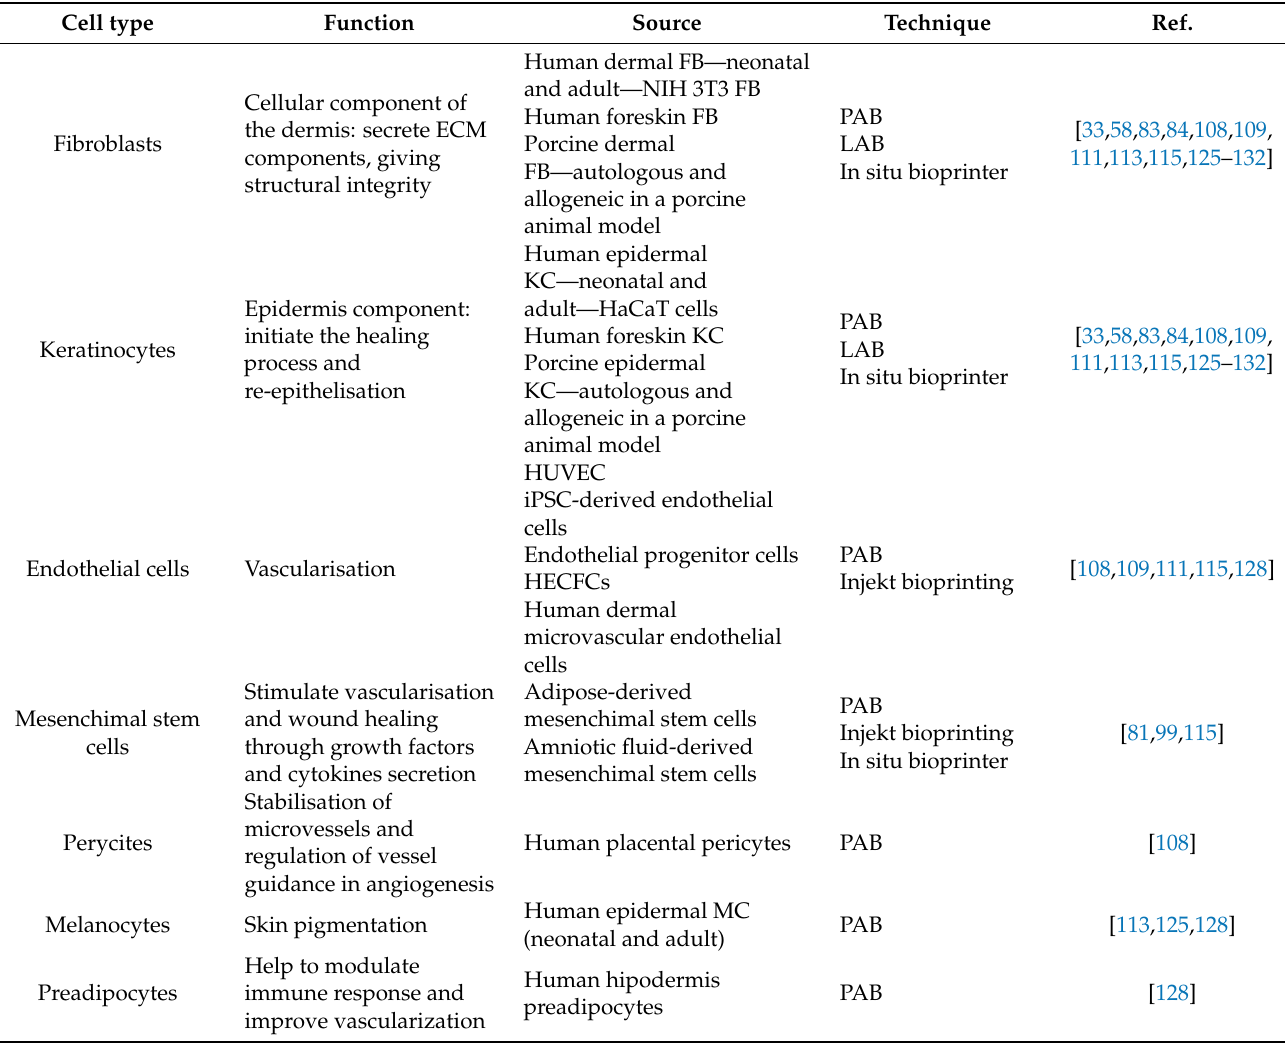
Table 2. Table summarising the cell types used in the development of bioprinted skin constructs. (FB: fibroblasts, KC: ker- atinocytes, PAB: pressure-assisted bioprinting, LAB: laser-assisted bioprinting, HUVEC: human umbilical vein endothelial cells, iPSC: induced pluripotent stem cell, HECFCs: human endothelial cells cord blood human endothelial colony-forming cells, MC: